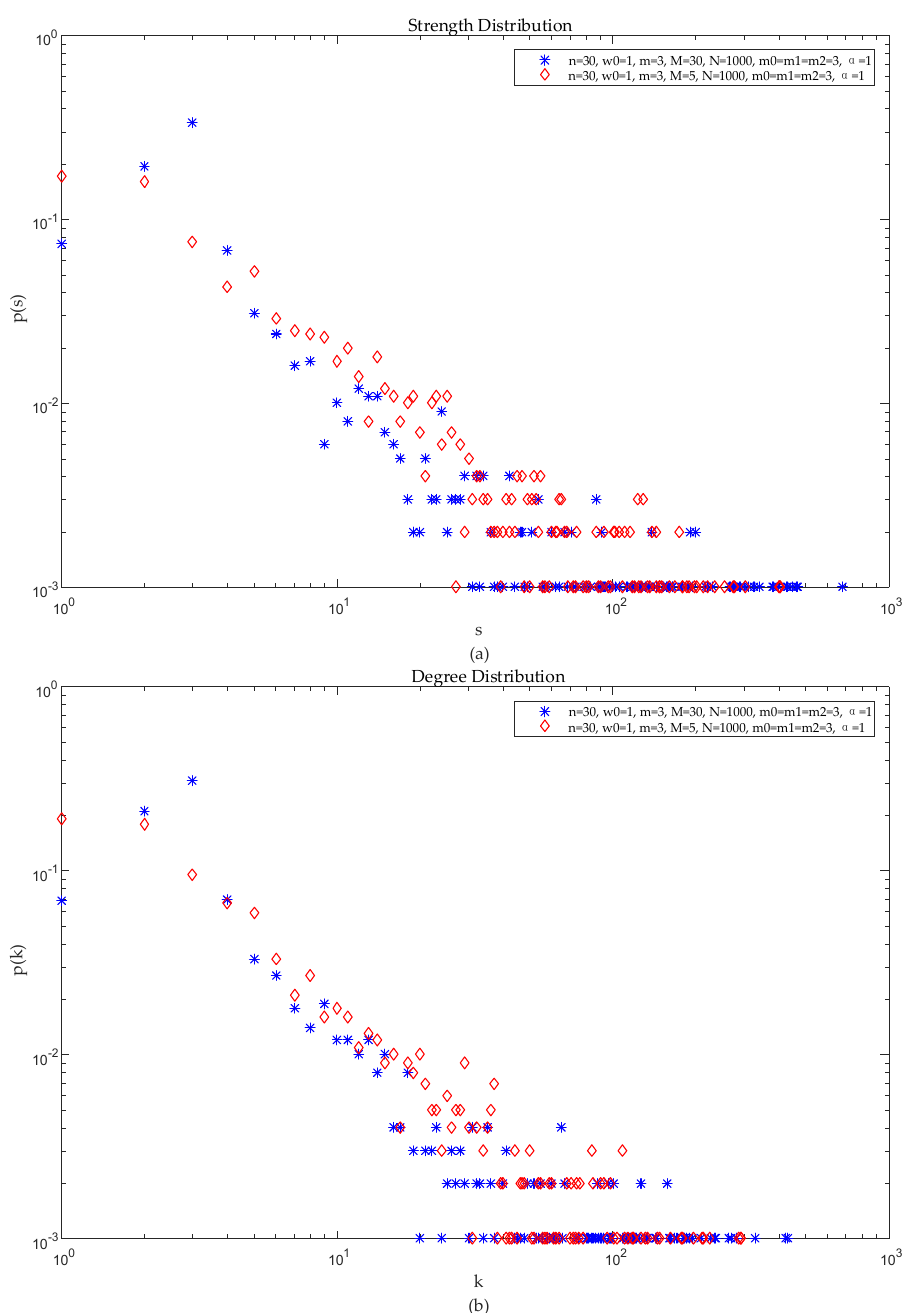
Figure 6. Analysis of the influence of local-world M on network structure performance: ( a ) Distribution of node strength; ( b ) Distribution of node degree.